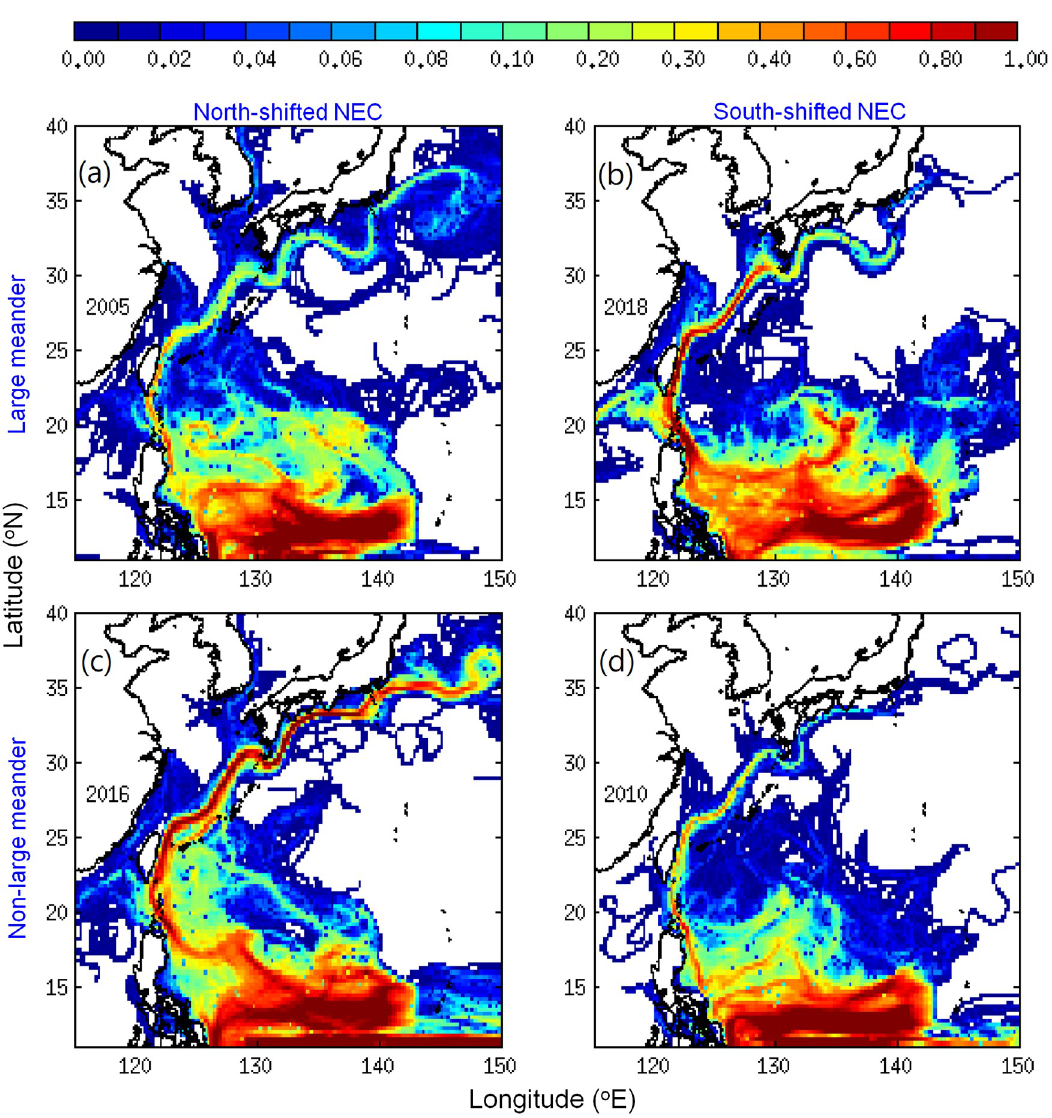
Fig 4. Visitation frequency distributions of v-larvae at the end of April during the late recruitment period in Kuroshio large meander years (a, 2005, b, 2018) and normal years (c, 2016, d, 2010). The unit of visitation frequency was normalized by the total number of released